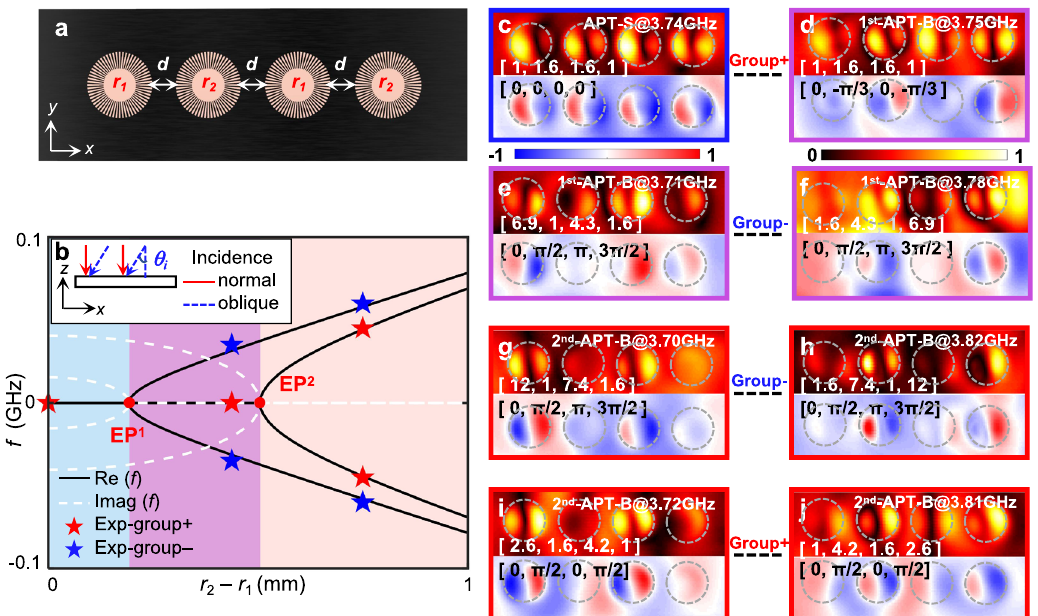
Fig. 5 | Observation of multi-stage APT phase transitions under space-wave illuminations. a The top view of the higher-order APT system. From left to right, theinnerradiiof thefourDSPRsare r 1 , r 2 , r 1 ,and r 2 ,respectively. b Thereal(black) and imaginary part (white) of the calculated eigenvalues of the system versus the detuning r 2 − r 1 .Theblue,purpleandpinkregionsdenotetheAPT-S,1st-APT-Band 2nd-APT-B phases, respectively. The red dots represent the EPs. Stars mark the